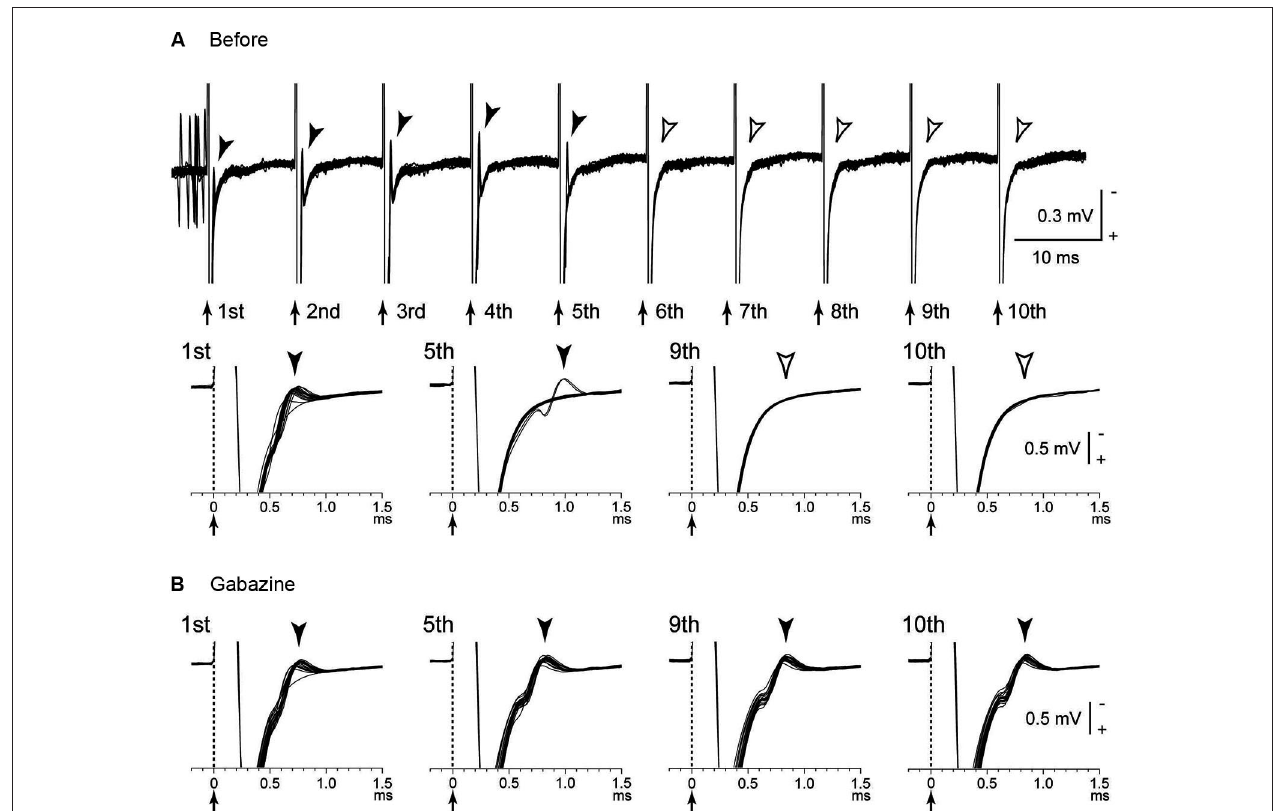
indicate directly evoked spikes. GPi-HFS failed to evoke spikes (open arrowheads; from 6th to 10th stimuli). (B) Effects of local gabazine injection on the inhibition of direct evoked GPi responses. Gabazine injection decreased failure rate, and each stimulus successfully evoked spikes (5th, 9th, and 10th stimuli). Modified from Chiken and Nambu